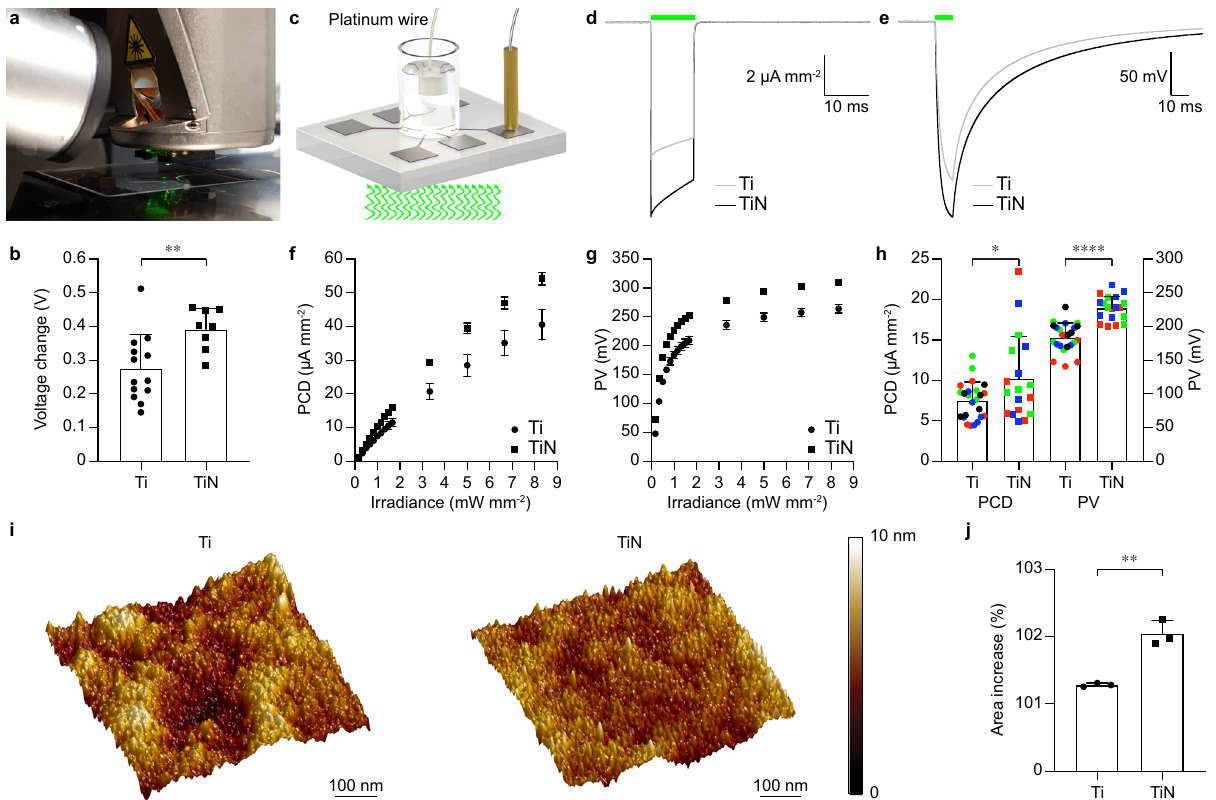
Fig. 3 Optoelectronic characterisation of the photovoltaic pixel. a Picture of the KPFM setup. b Surface voltage changes obtained with Ti (circles) and TiN-coated (squares) cathodes. Each bar is the mean (± s.d.) of the measures from n = 13 Ti pixels and n = 8 TiN-coated pixels. c Drawing of the experimental setup for the measure of the PC and PV; the light pulse comes from the bottom. d , e Mean PCD ( d ) and PV ( e ) measures obtained from Ti (grey) and TiN-coated (black) pixels upon illumination (565 nm, 10 ms, 0.9 mW mm − 2 ). For Ti, n = 24 pixels from four chips were averaged; for TiN, n = 18 pixels from three chips were averaged. f , g Mean (± s.e.m) PCD ( f ) and PV ( g ) amplitudes quanti fi ed at increasing irradiance levels (565 nm, 10 ms) for Ti pixels (circles; n = 24 pixels from four chips) and TiN-coated pixels (squares; n = 18 pixels from three chips). h Mean (± s.e.m) PCD and PV amplitudes quanti fi ed at 0.9 mWmm − 2 for Ti ( n = 24 pixels from four chips) and TiN-coated ( n = 18 pixels from three chips) pixels. i AFM images of the Ti and Ti/ TiN surfaces. The colour bar shows the surface roughness. j Mean (± s.d.) percental increase of the surface area compared to the nominal fl at area (500 × 500 nm 2